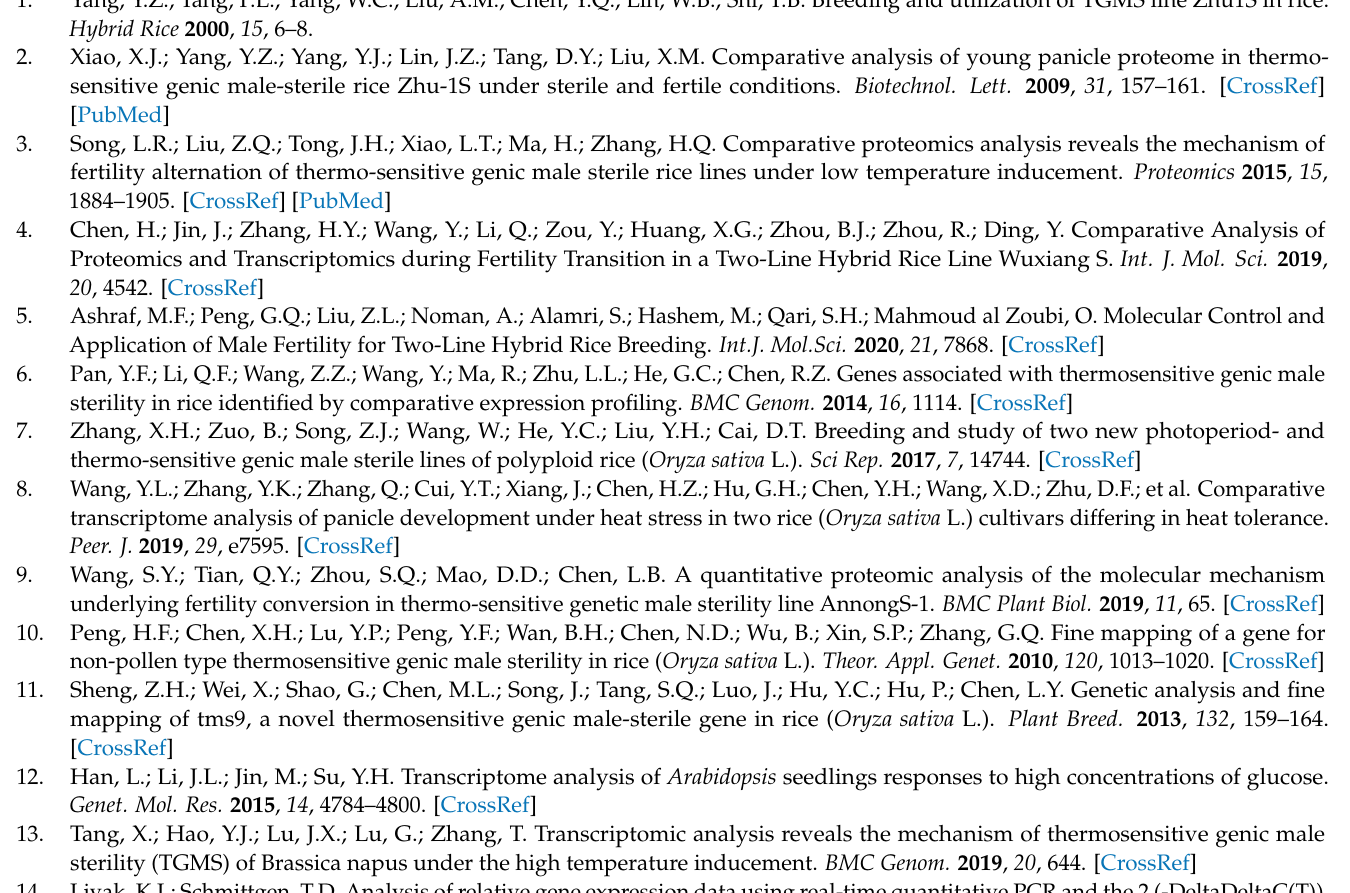
1S. Table S1. List of PCR Primers; Table S2. Preprocessing results of sequencing data quality; Table S3. Differentially expressed genes involved in transcription factor in Zhu 1S under high